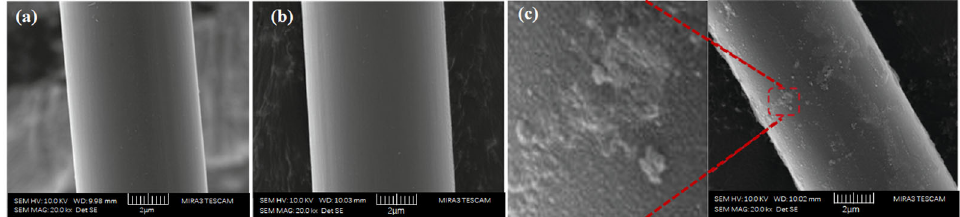
Figure 5. ( a ) Ordinary CFs; ( b ) CFs treated with nitric acid; ( c ) Nano-silica coated on the surface of CFs [41].